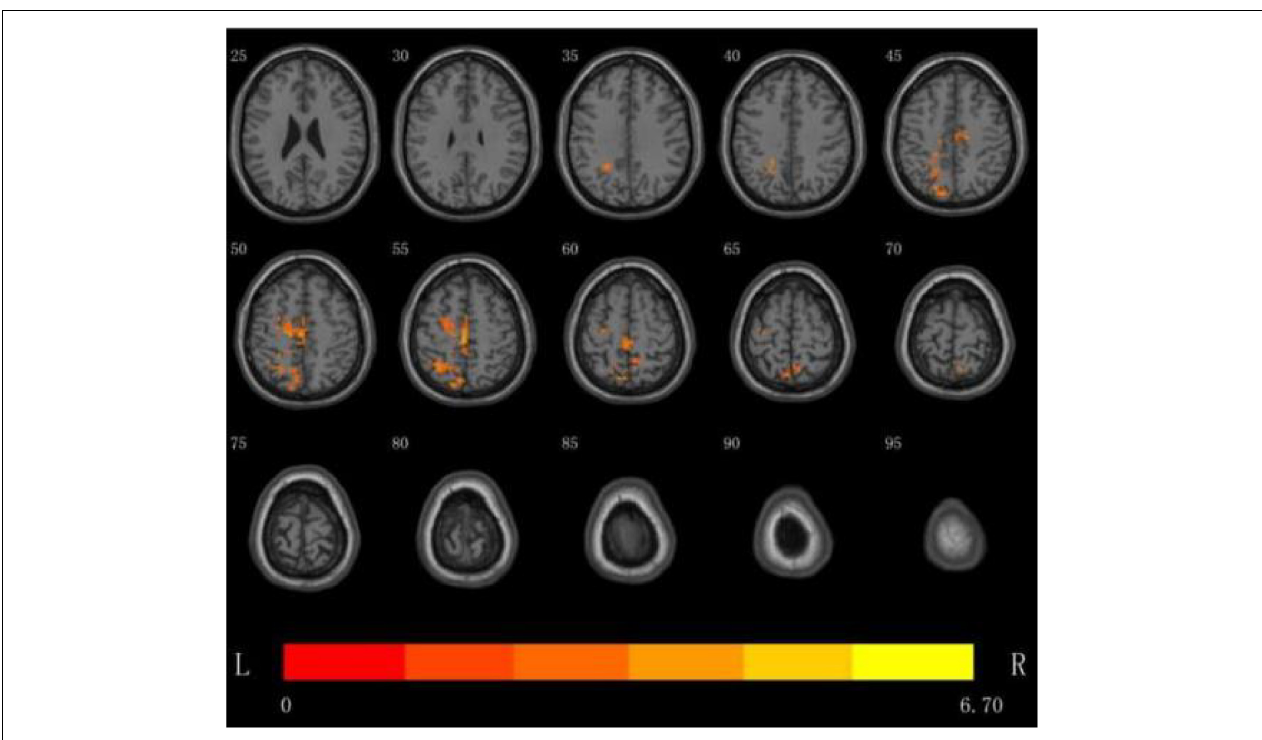
FIGURE 2 | DC analysis of the distribution of brain regions with significant differences between the two groups before and after treatment, the yellow area is the activated brain area (threshold: individual level P < 0.05, clump level P < 0.05).